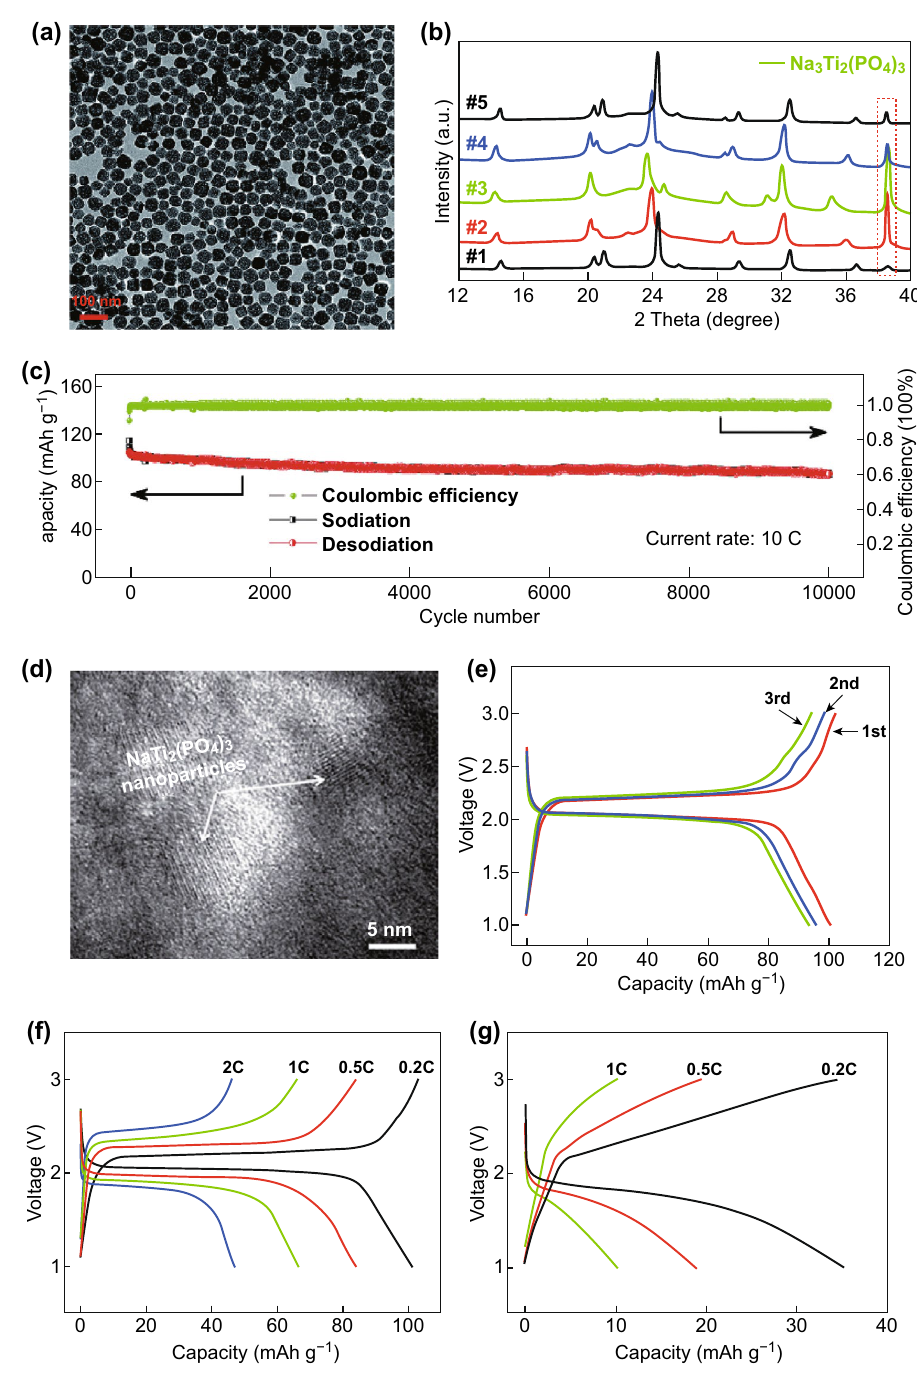
Fig. 2 a TEM image of typical NTP nanocubes obtained via a one-pot solvothermal method. b XRD diffraction patterns recorded at different stages of NTP upon charging/discharging. The diffraction peak marked with a dark-wine-red-dashed box in b corresponds to the aluminum cur- rent collector. c Cycling performance of NTP electrodes obtained at current rates of 10 C [48]. Copyright 2015, the Royal Society of Chemistry. d HRTEM images of the mesoporous NTP/CMK-3 nanohybrid electrode after 1000 cycles at the rate of 0.5 C. e The first three charge–discharge profiles of the NTP/C electrode at 0.2 C. f Galvanostatic charge–discharge (GCD) plots of NTP/C and g pure NTP anodes at various